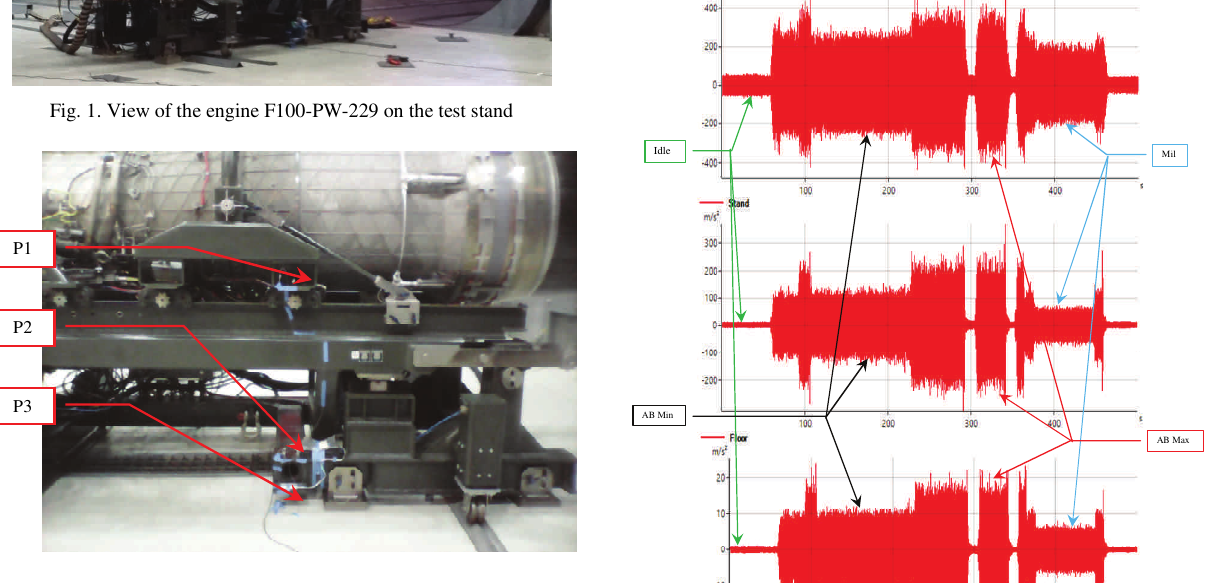
Fig. 2. Distribution of acceleration transducers on the test stand, engine F100-PW-229